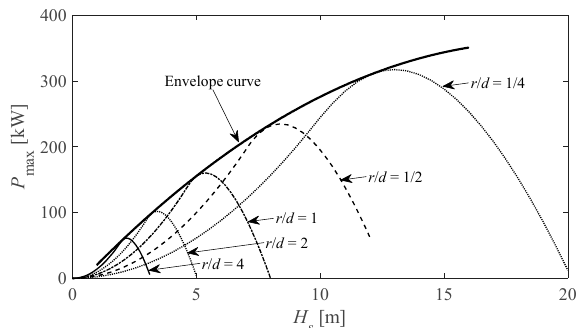
Figure 8. The maximum absorbed power P max as a function of the significant wave height H s for vertical truncated cylindrical buoys with different radius-to-draft ratios r / d at the energy period of T e = 8 s.